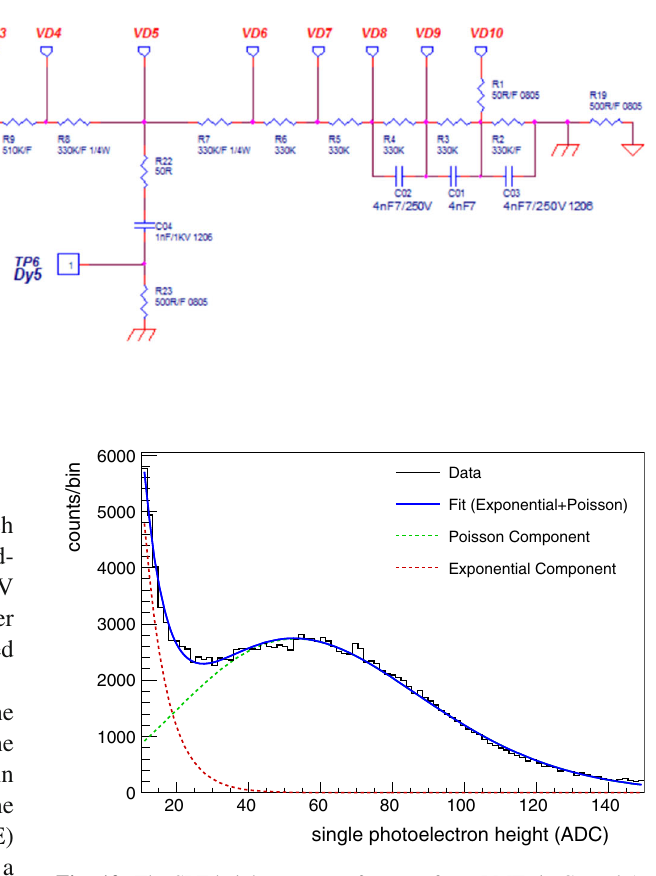
Fig. 12 The SPE height spectrum for one of two PMTs in Crystal-1 and SADCs. All of the crystal, LS, and muon-detector PMT signal data are stored for FADC triggers. For each FADC channel, this corresponds to an 8 µ s-long waveform